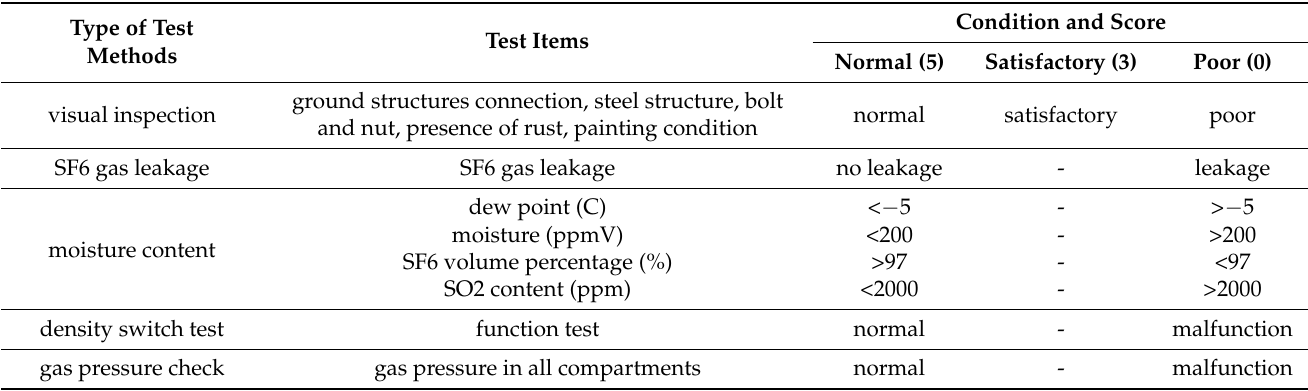
Table 7. SF6 gas compartment testing methods and visual